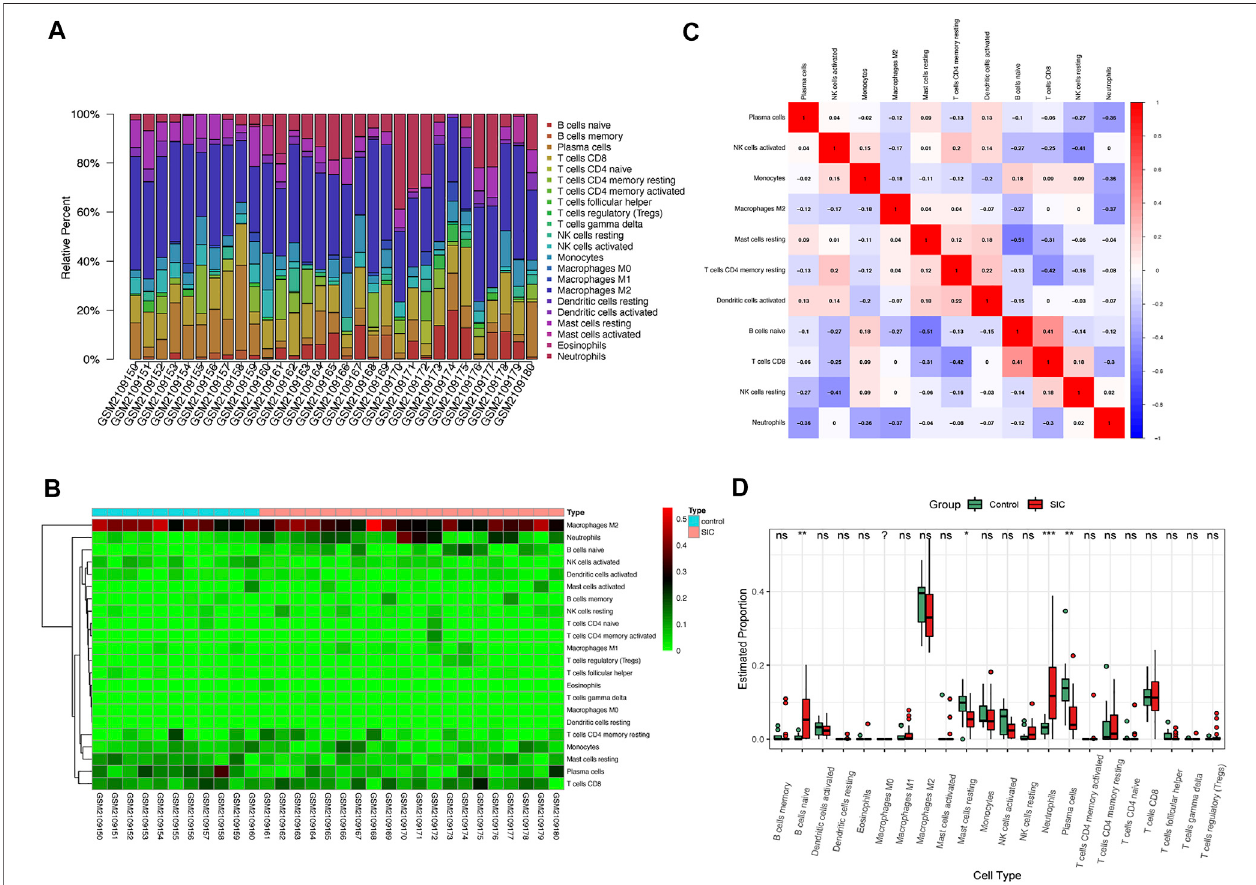
FIGURE 6 | Immunocytes in fi ltration of control groups compared to SIC groups. (A) Proportional values of 22 immunocytes. (B) Heatmap of 22 kinds of immunocytes. (C) Cor-heatmap showing co-relationship of 11 main immunocytes. (D) Differences of in fi ltration between controls and SIC counterparts. Red boxes stand for the SIC samples. *: p < 0.05, **: p < 0.01, ***: p < 0.001, SIC: sepsis-induced